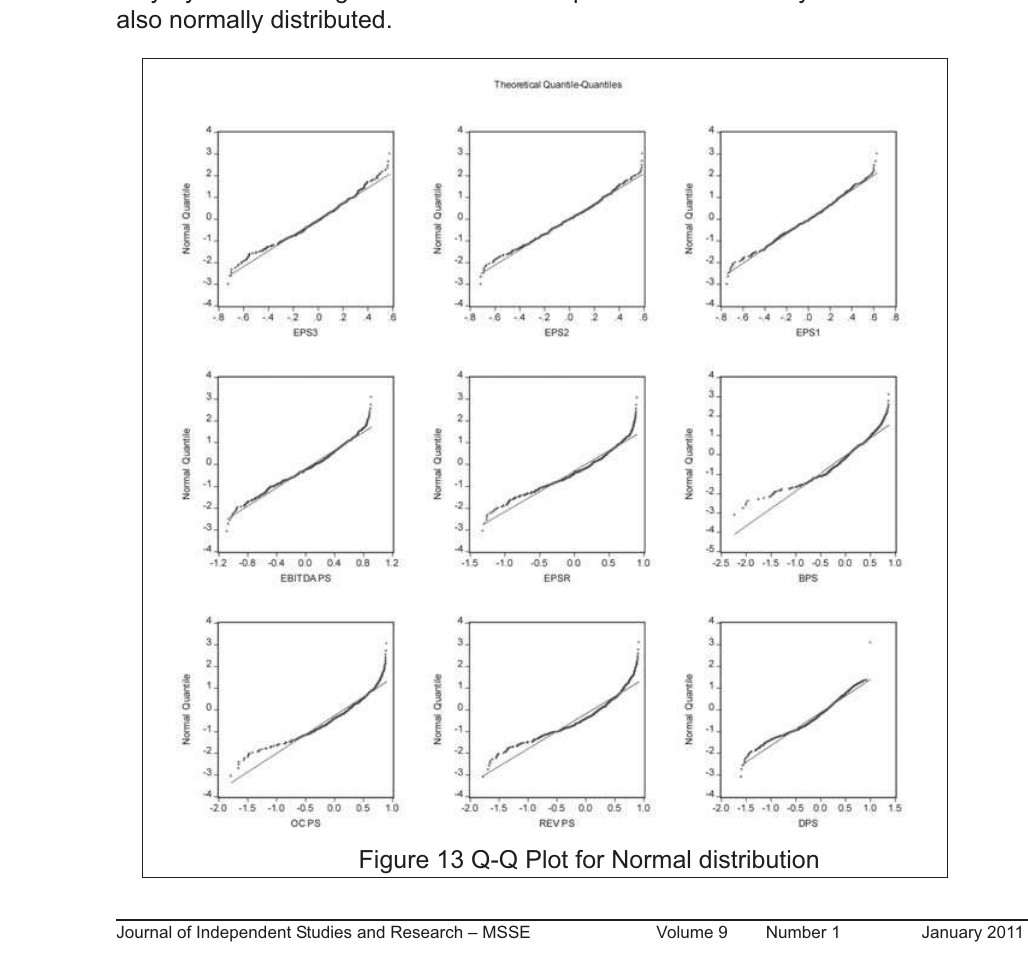
Figure 13 Q-Q Plot for Normal